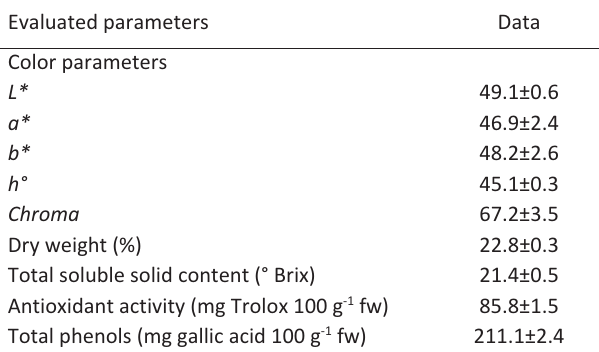
Table 2 ­ Color parameters, dry weight, total soluble solid con­ tent, antioxidant activity and total phenols